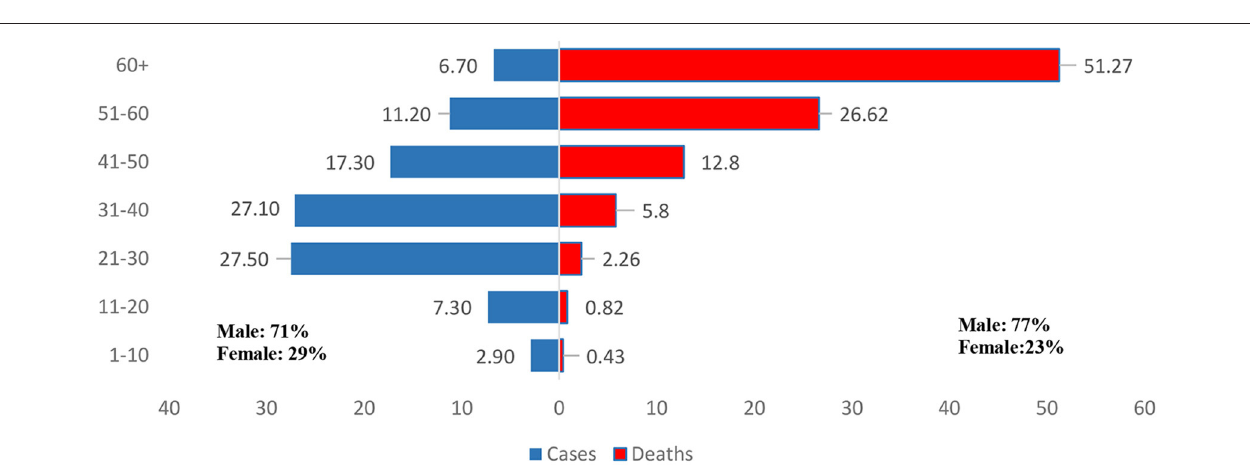
FIGURE 5 | Age distribution of cases and deaths in Bangladesh.